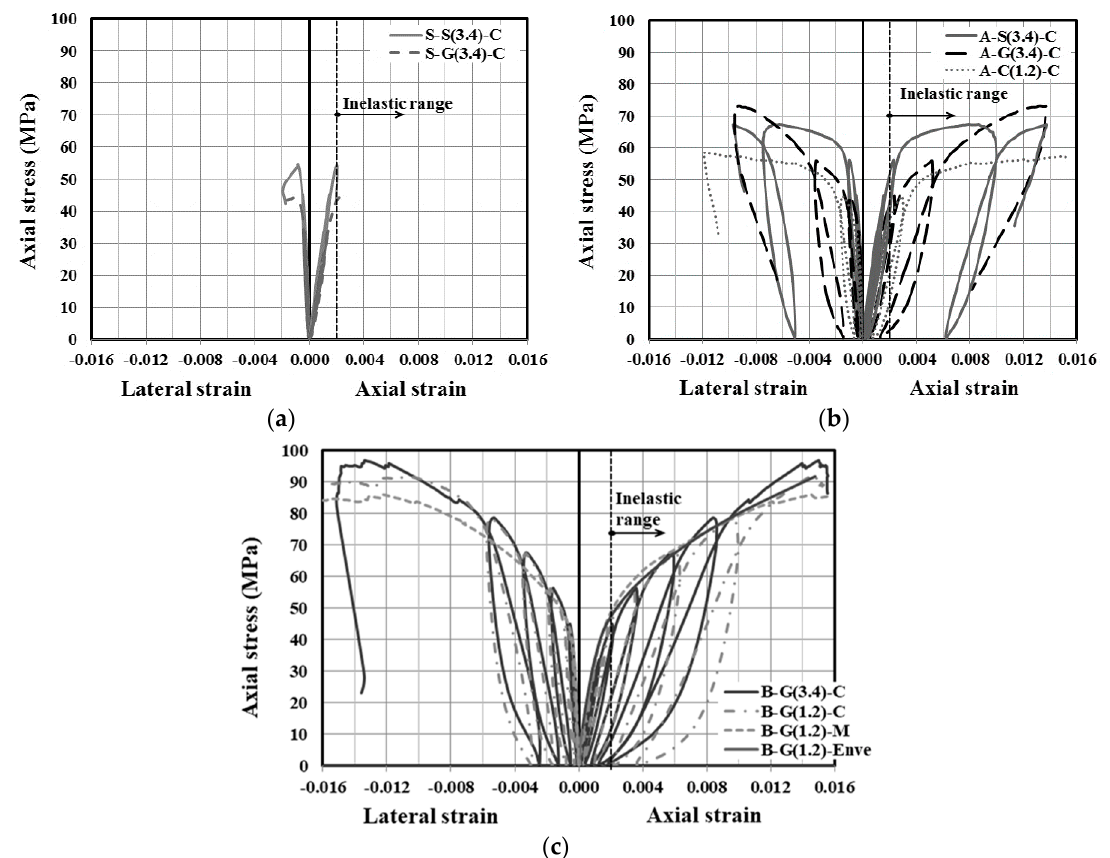
Figure 8. Axial cyclic stress-strain curves for the: ( a ) Control columns; ( b ) reinforced-CFFT columns confined with tube type A; ( c ) reinforced-CFFT columns confined with tube type B.